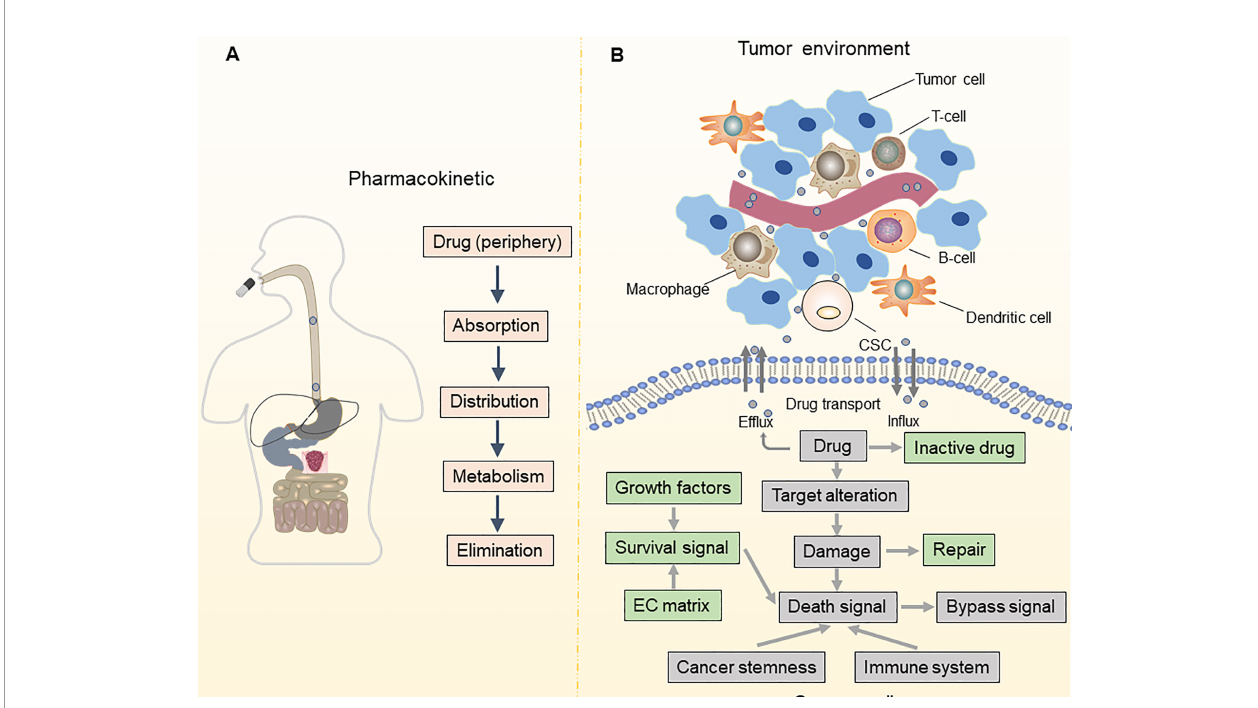
FIGURE 1 | Pharmacokinetic and TME-associated factors contribute to drug resistance. (A) Mechanisms of drug resistance can be due to pharmacokinetics, including drug absorption, distribution, metabolism, and elimination; (B) Alterations in drug in fl ux and ef fl ux system impact the intracellular accumulation of anti- cancer drugs in tumor cells. The leading determinants of drug resistance are altered in drug targets, bypass signaling pathways, DNA damage and repair, and cell death signaling. Besides, maintenance of cancer stemness and a tumor-promoting immune microenvironment also contribute to drug